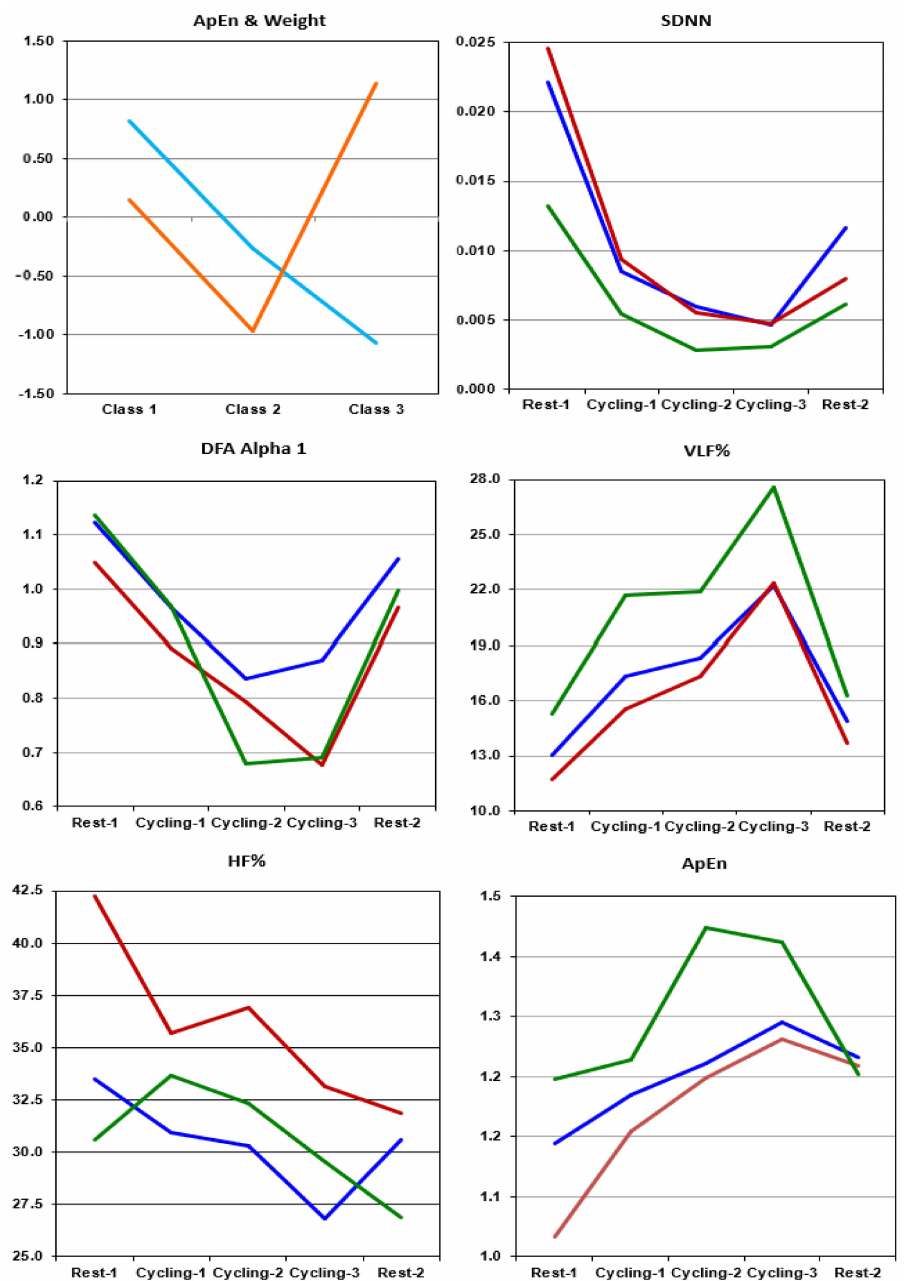
Figure 1. Normalized ApEn values and weight scores in the 3 classes as well as time–domain, frequency–domain and nonlinear HRV indices during Rest-1, Cycling-1, Cycling-2, Cycling-3 and Rest-2. At the top of left panel: cyan denotes normalized scores of weights and orange denotes normalized scores of ApEn values, respectively. The plots for HRV indices are shown in blue for Class 1, red for Class 2 and green for Class